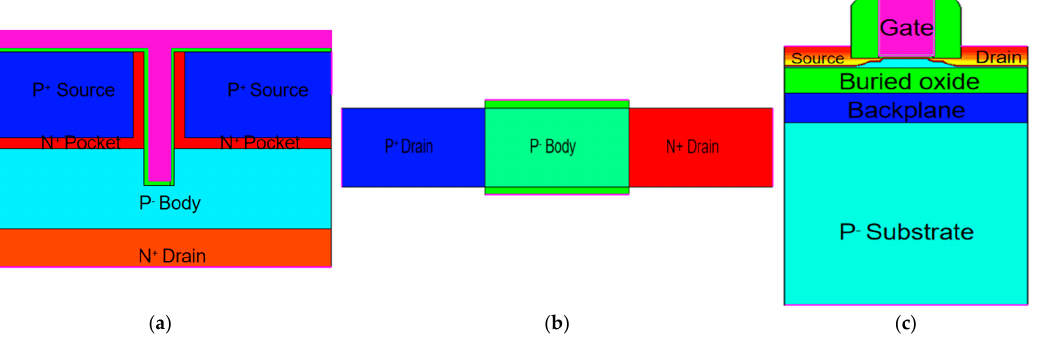
Figure 1. Cross ‐ sectional view of ( a ) TGTFET, ( b ) DGTFET, and ( c ) FDSOI MOSFET considered in this paper.